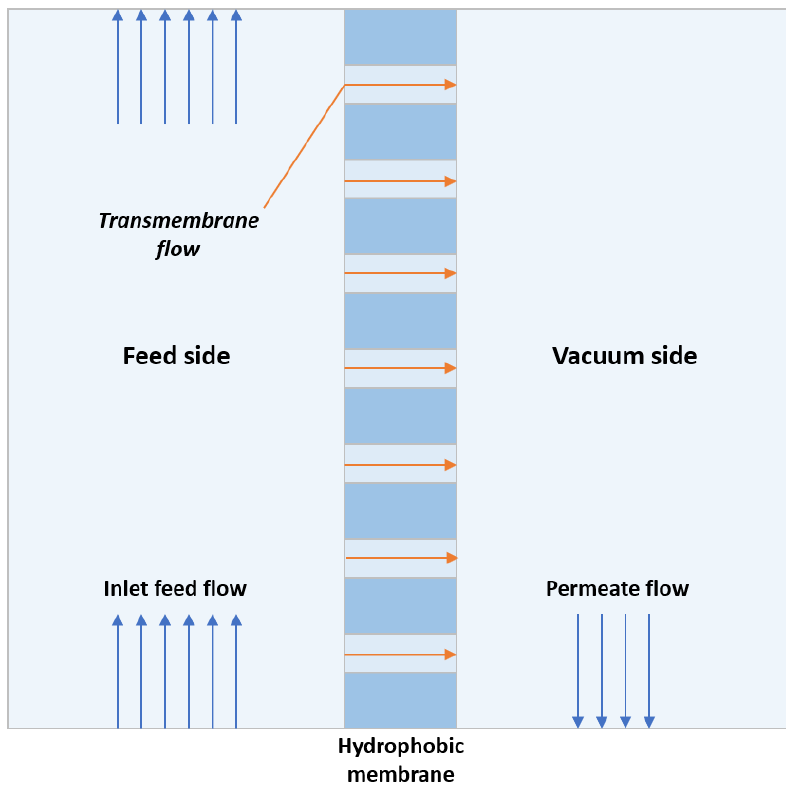
Figure 2. Schematic diagram of VMD